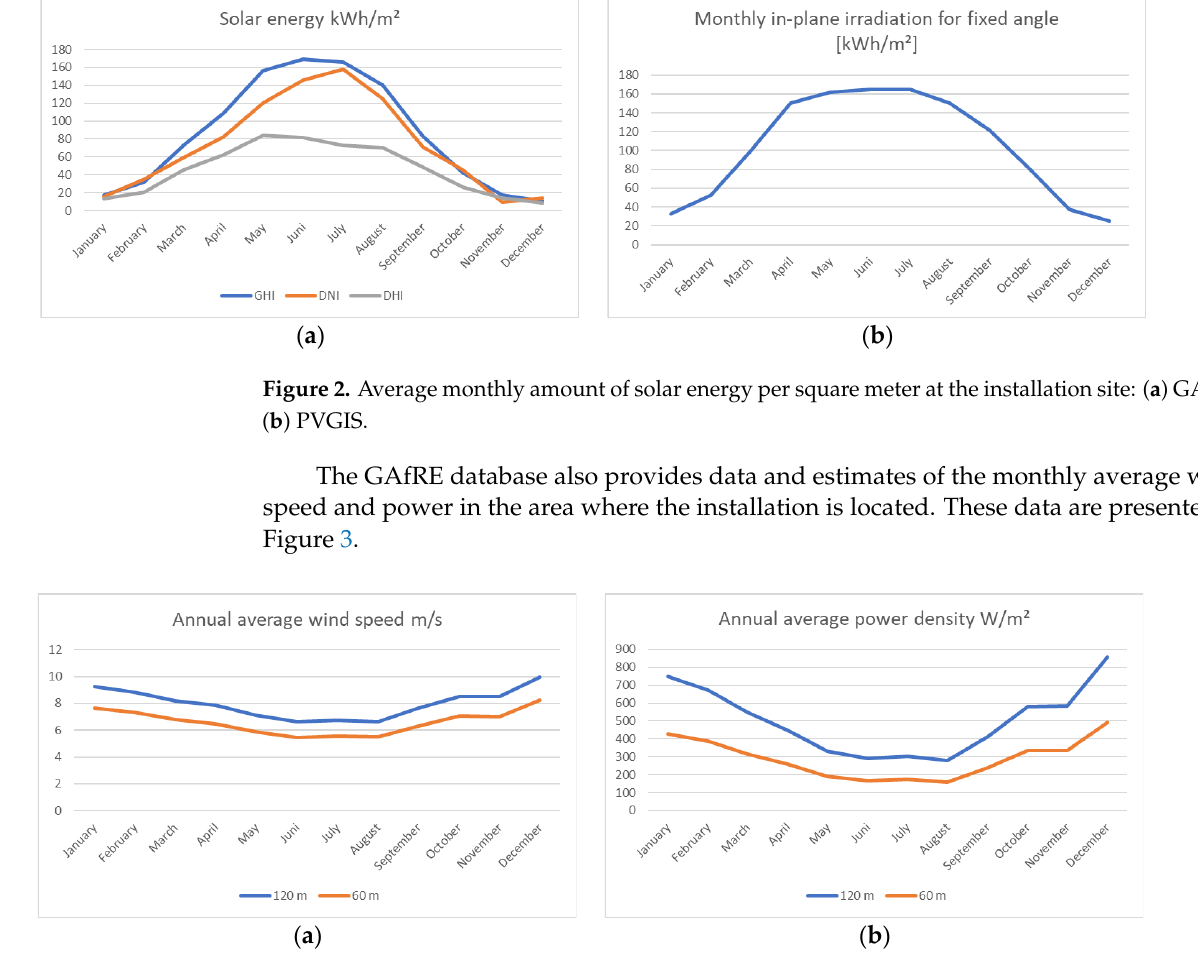
Figure 3. Average monthly: ( a ) wind speeds; ( b ) power density at the installation